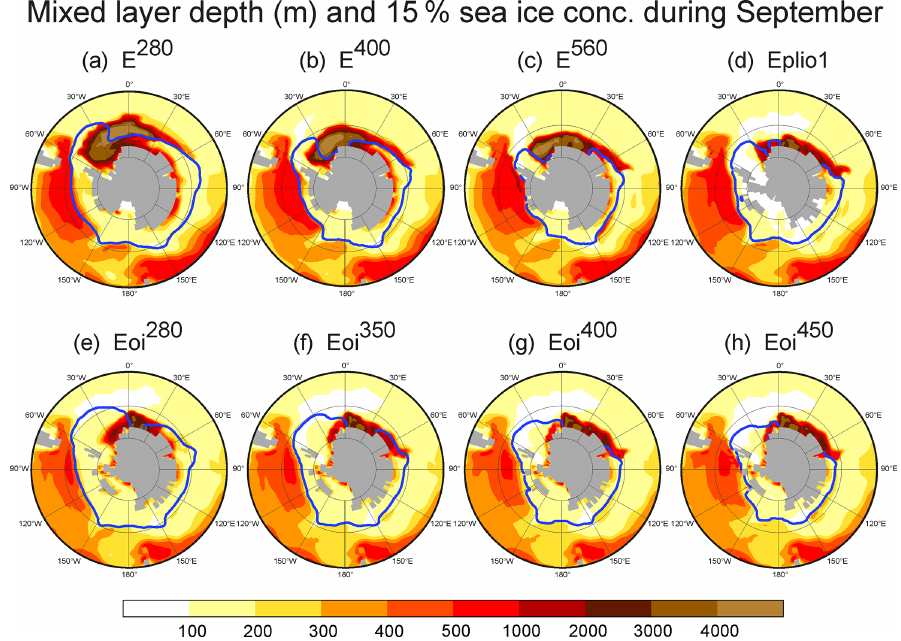
Figure 10. Oceanic mixed layer depth in the Southern Hemisphere during September. The blue lines indicate the extent of 15% sea ice concentration. For a comparison of PlioMIP1 and PlioMIP2, see (d, g) . For the individual effects of CO 2 and Pliocene boundary conditions, see (b, e) ,